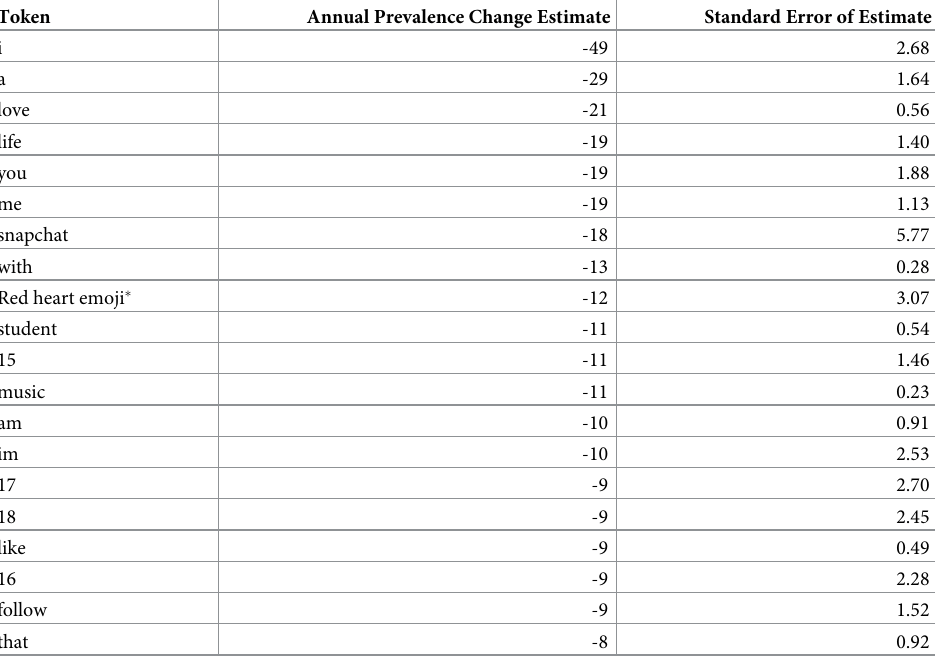
Table 5. Top 20 loser tokens in the longitudinal